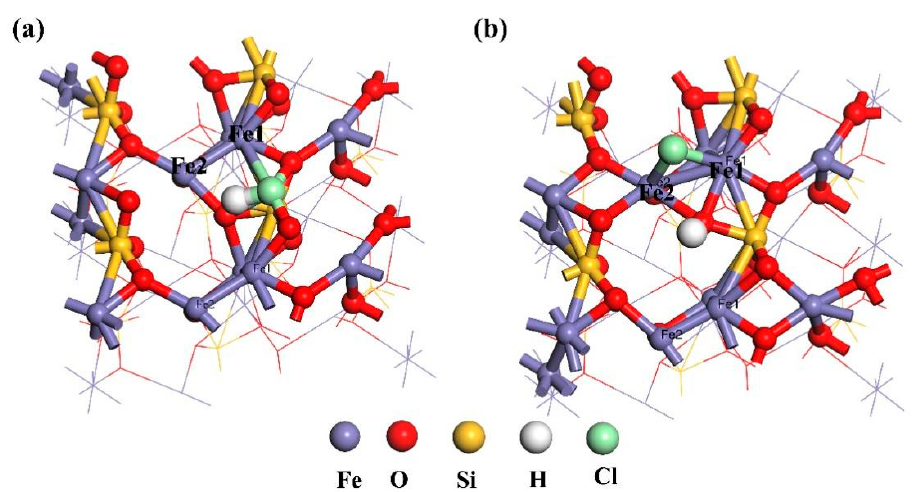
Figure 7. HCl adsorption on Fe 2 SiO 4 : ( a ) HCl adsorption on Si site before optimization. ( b ) HCl adsorption on Si site after optimization.